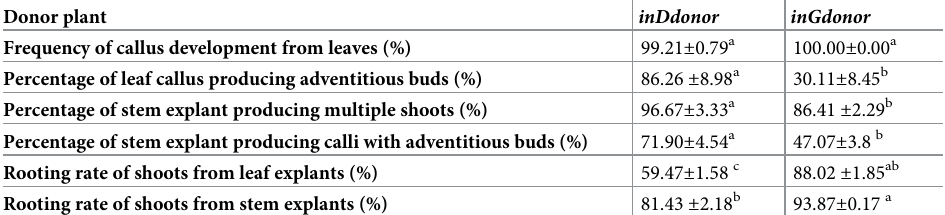
Table 1. Effect of genetic background on callus, multiple shoot, adventitious bud and root induction in L . ruthenicum .